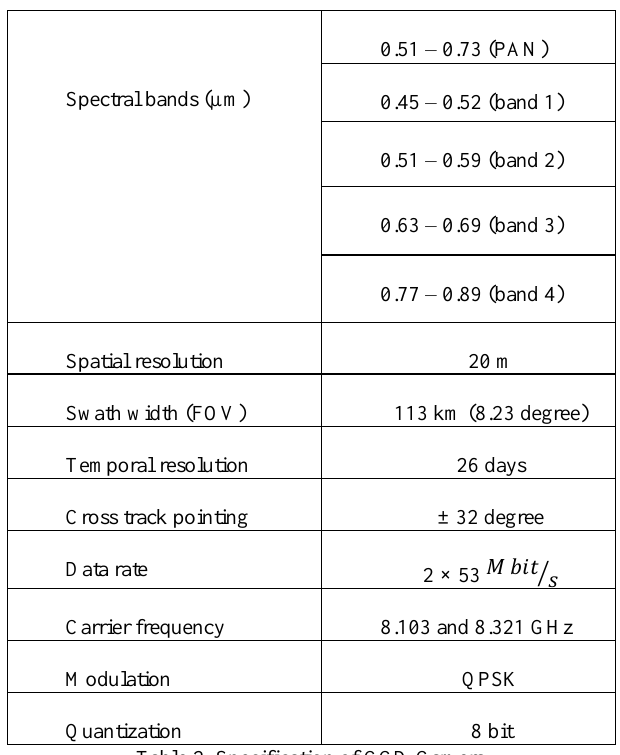
Table 2. Specification of CCD Camera